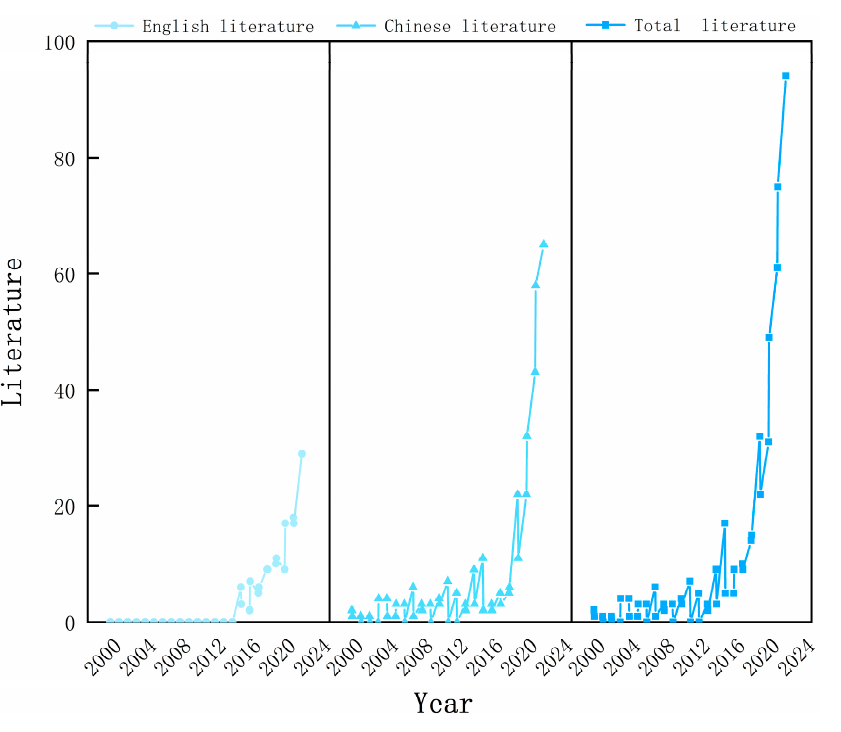
Figure 2. The pattern in the yearly distribution of the study of the realization of eco-product value and the eco-industry.